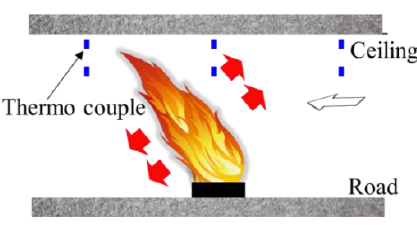
Figure 12. Tilt of the fire plume due to the upstream longitudinal velocity.